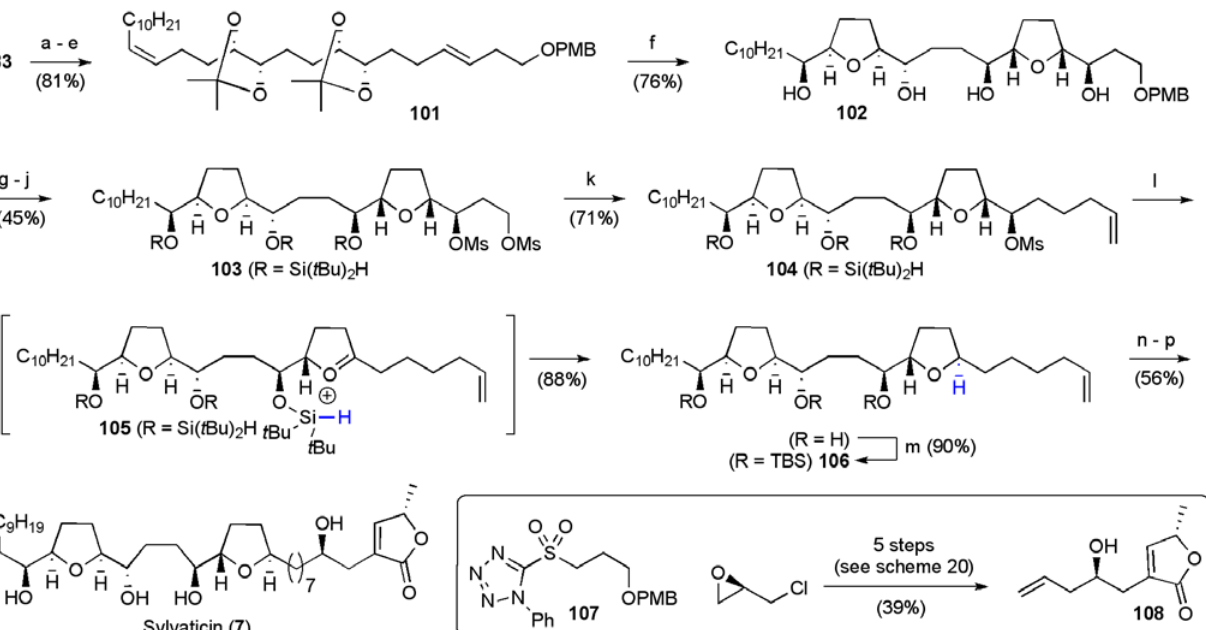
Scheme 26. Synthesis of sylvaticin ( 7 ).